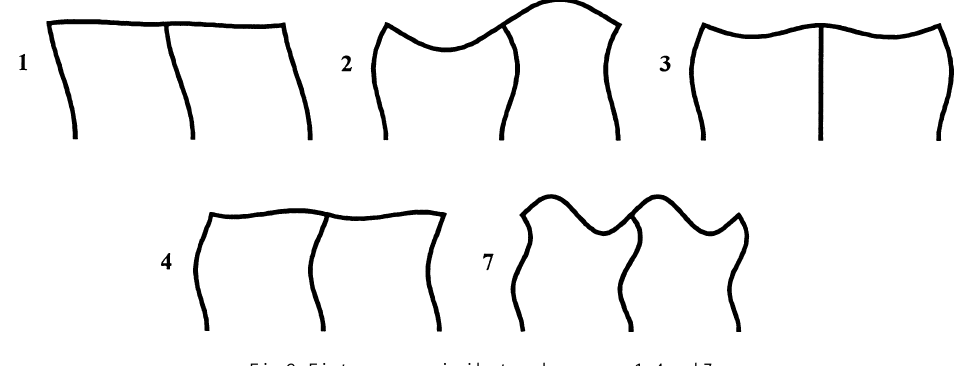
Fig. 2. First five non-coincident modes, = nos. 1–4 and 7.